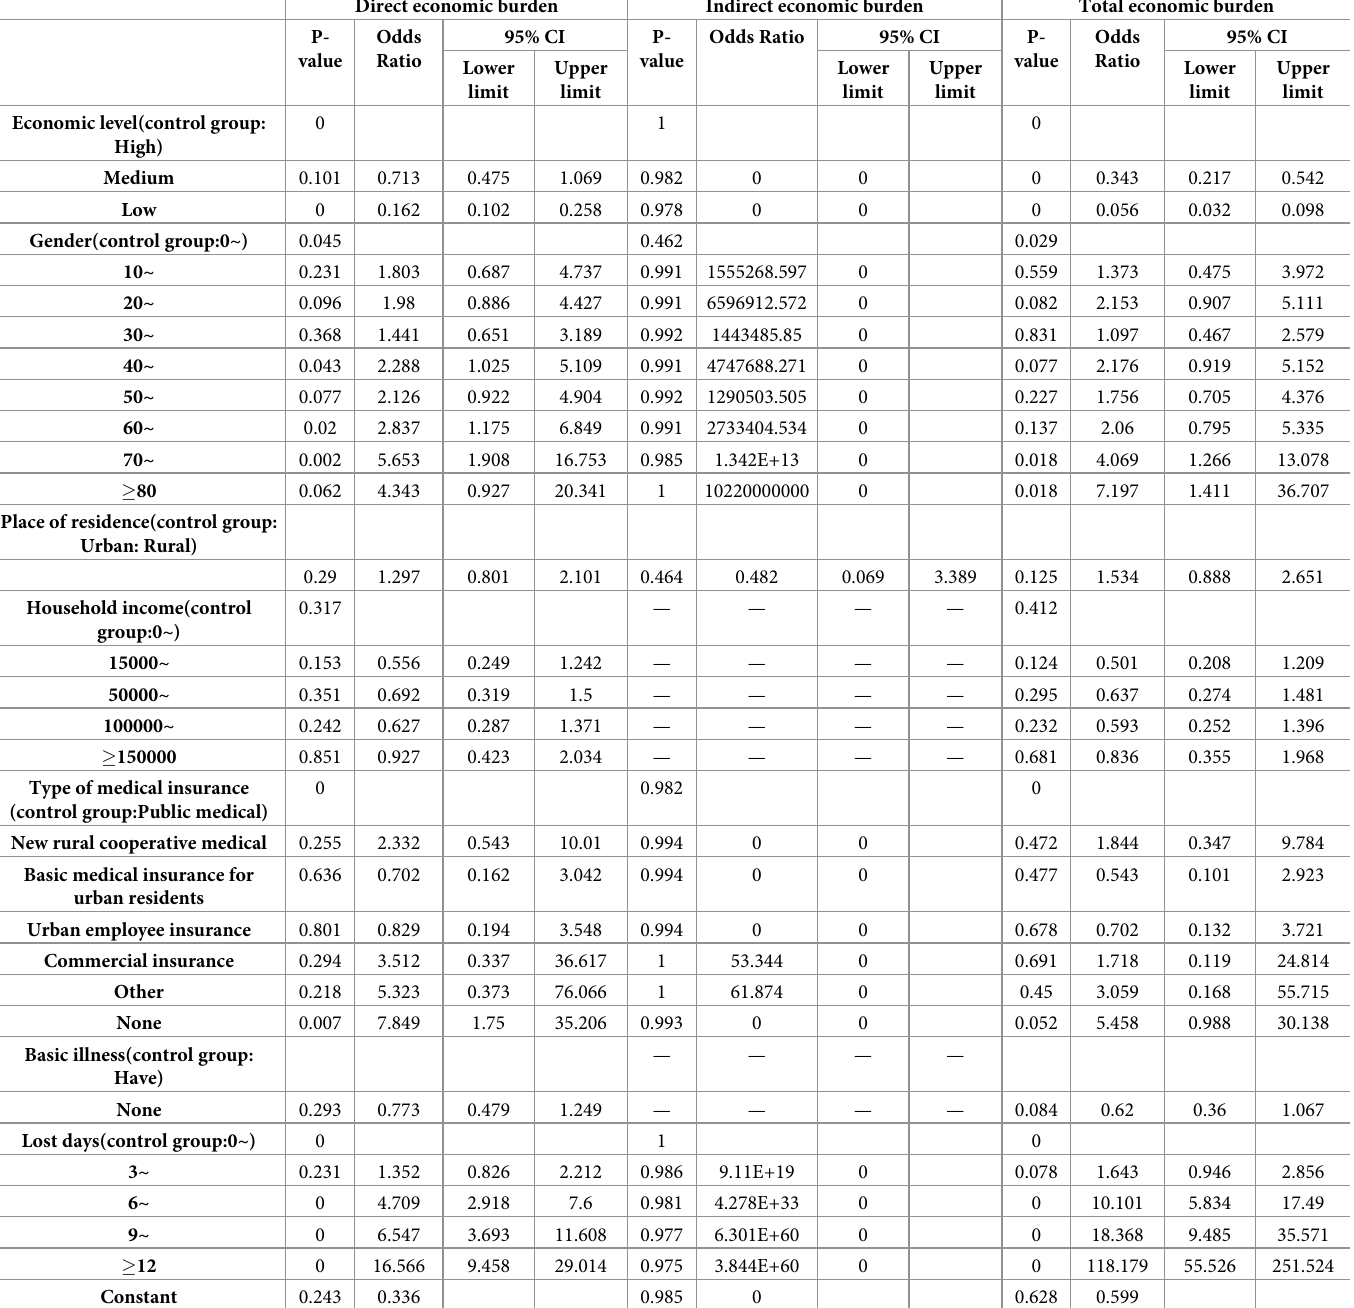
Table 2. Multivariate logistic regression analysis of dengue fever patients’ economic burden. Direct economic